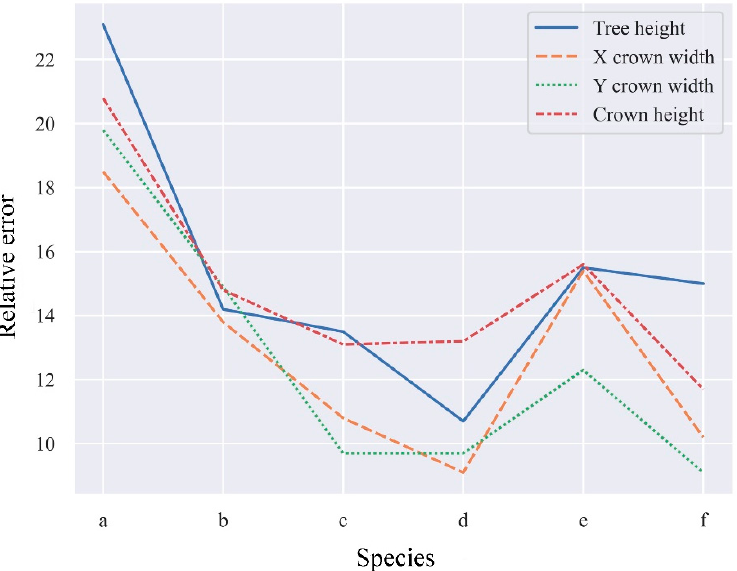
Figure 5. Differences in tree attribute extraction results for different tree species. a, b, c, d, e, and f represent Fraxinus pennsylvanica , Ginkgo biloba , Robinia pseudoacacia , Acer negundo , Populus tomentosa , and Koelreuteria paniculate , respectively.